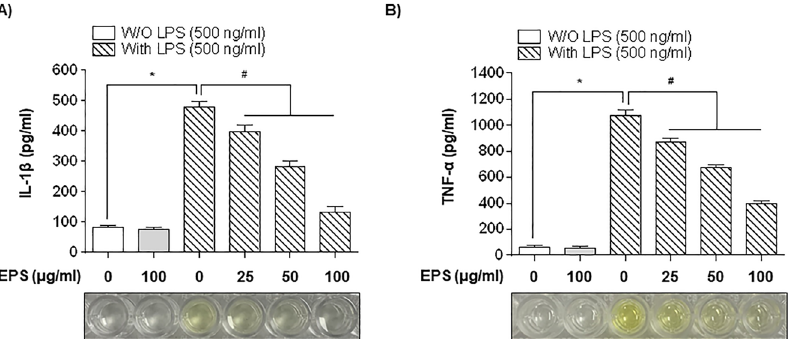
Figure 5: Effect of EPS on lipopolysaccharide (LPS)-stimulated tumor necrosis factor (TNF)- α and interleukin (IL)-1 β production in RAW 264.7 cells. Cells were pretreated with the indicated concentrations of EPS (25, 50, and 100 µg/mL) for 1 h prior to incubation with LPS (500 ng/mL). After incubationfor24h,thelevelsofIL-1 β (A)andTNF- α (B)presentinthesupernatantsweremeasuredusingELISAkits.Eachvalueispresentedas the mean ± SD and is representative of the results obtained from three independent experiments. The signi fi cance was determined by the